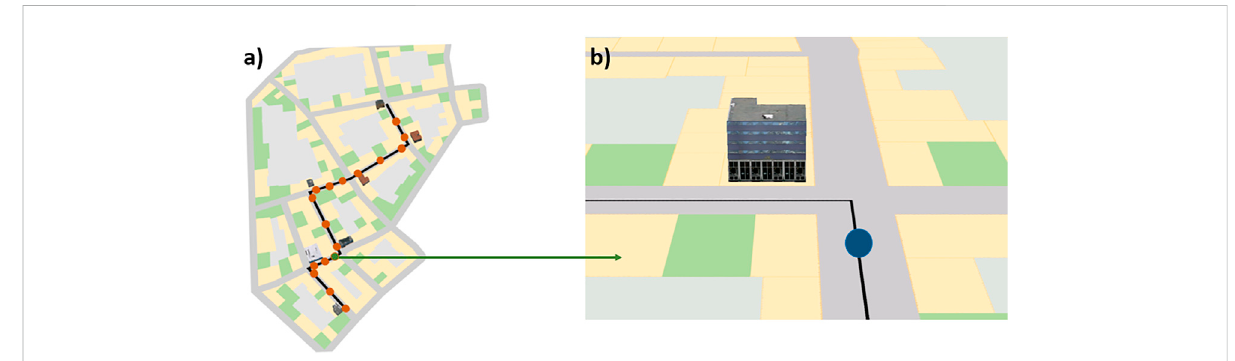
FIGURE 3 (A) Red dots along the black navigation route indicate the 17 map pop-up spots during navigation; (B) a mobile map that rotates along with the participant ’ sheaddirection,asseenbytheparticipantatthelocationofthegreendotinpanel (A) .Thebluedotinpanel (B) indicatestheparticipant ’ s current location in the virtual city. The black line indicates the path the participant needs to follow. A 3D landmark building or an imprint of the building is shown on the map at a turning intersection, depending on the landmark condition.